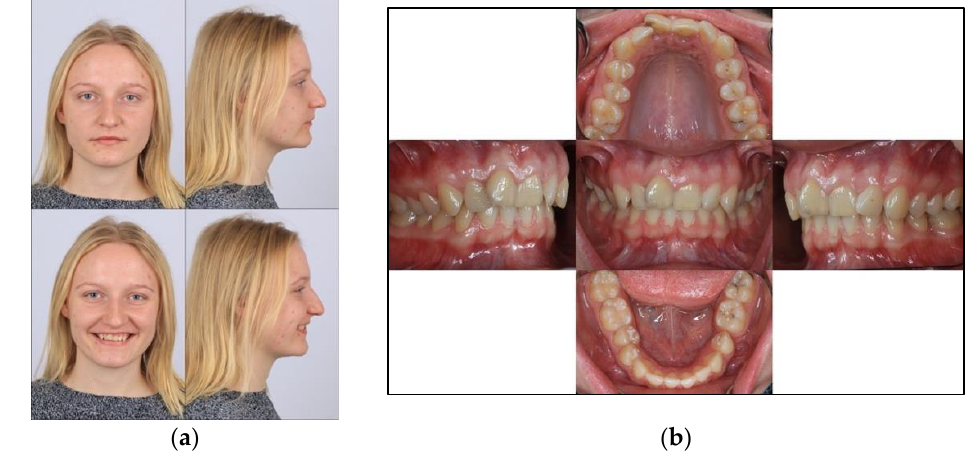
Figure 2. Initial pictures of patient in case number 1: ( a ) extraoral pictures, and ( b ) intraoral pic- tures.